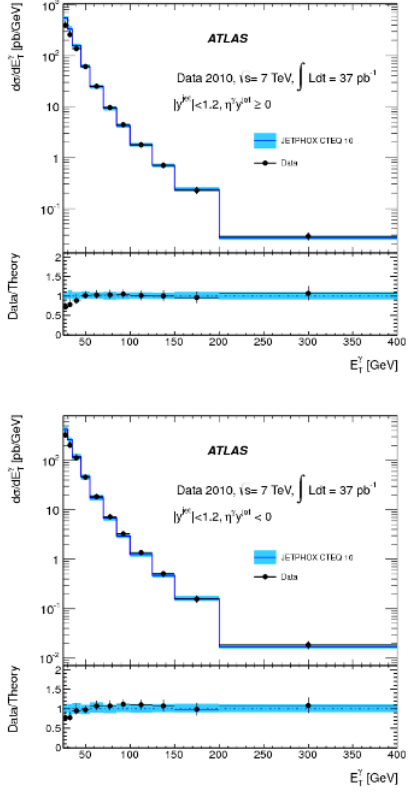
Figure 1. Experimental (black dots) and theoretical (blue line) photon plus jet production cross sections, for sign (Upper) and opposite-sign (Lower) configurations. The black error bars represent the total experimental uncertainty. The blue bands show the total uncertainties on the theoretical pre- dictions obtained with JETPHOX. Bottom graphs: ratio between the measured and predicted cross sections. The blue band shows the theoretical uncertainties while the error bars show the exper- imental uncertainties on the ratio.